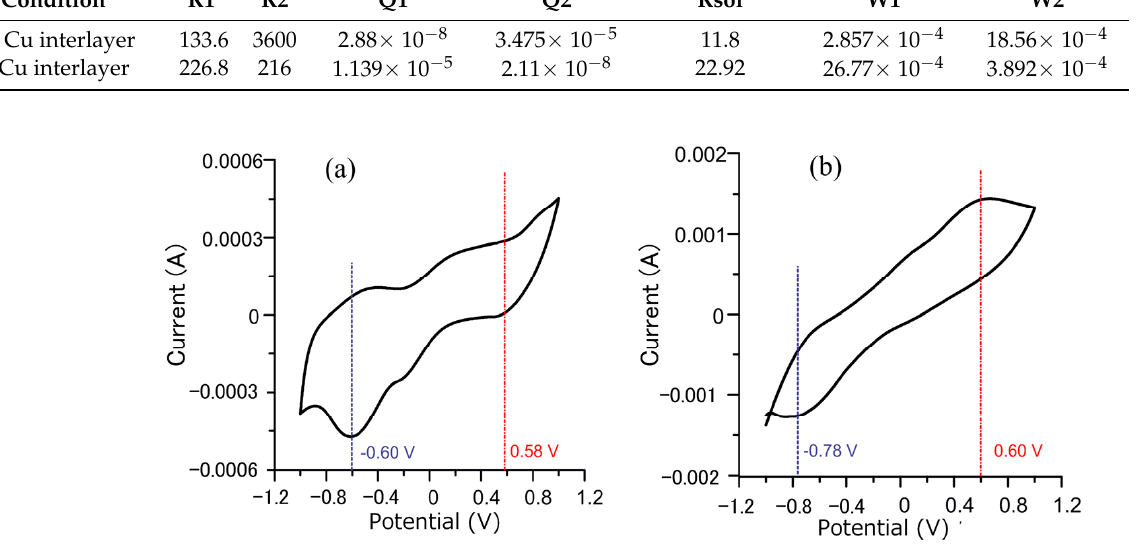
Figure 5. Cyclic voltammetry curves of the specimen ( a ) without Cu interlayer, and ( b ) with Cu interlayer.